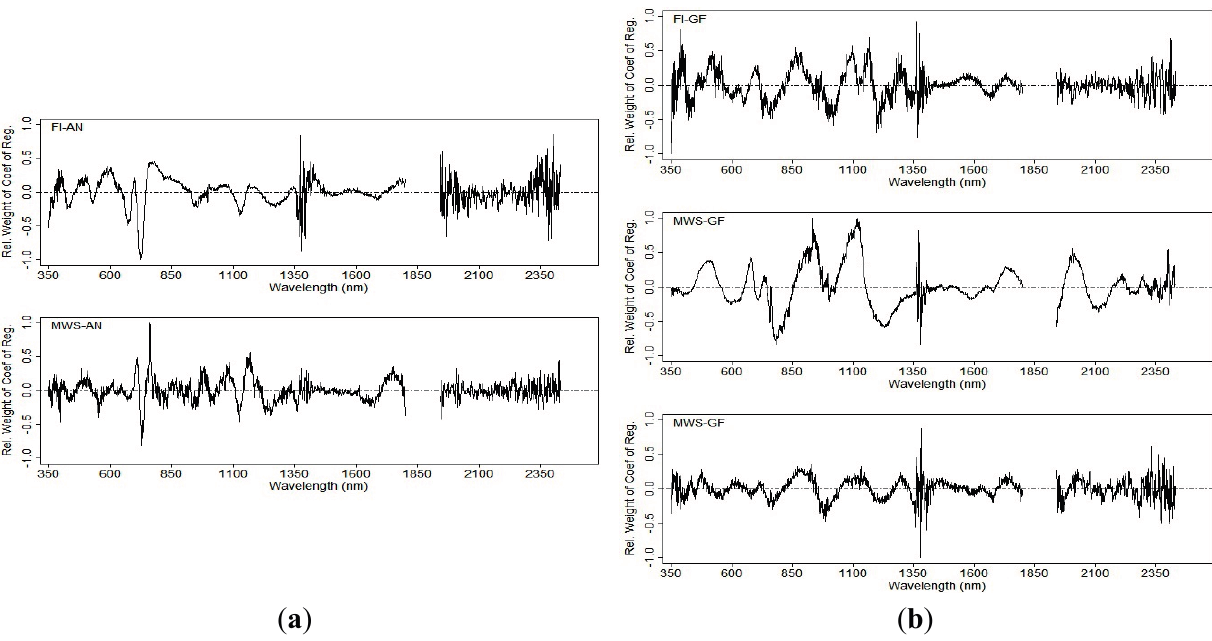
Figure 3. Relative weight of regression coefficients for each wavelength. Coefficients have been re-scaled, dividing them by the maximum absolute value for each model in order to simplify the comparison Data correspond to all environments (FI: full irrigation, MWS: medium water stress, SWS: severe water stress), and phenological stages (( a ) AN: anthesis and ( b ) GF: grain filling). Coefficients were generated after the calibration of each environmental and phenological stage.